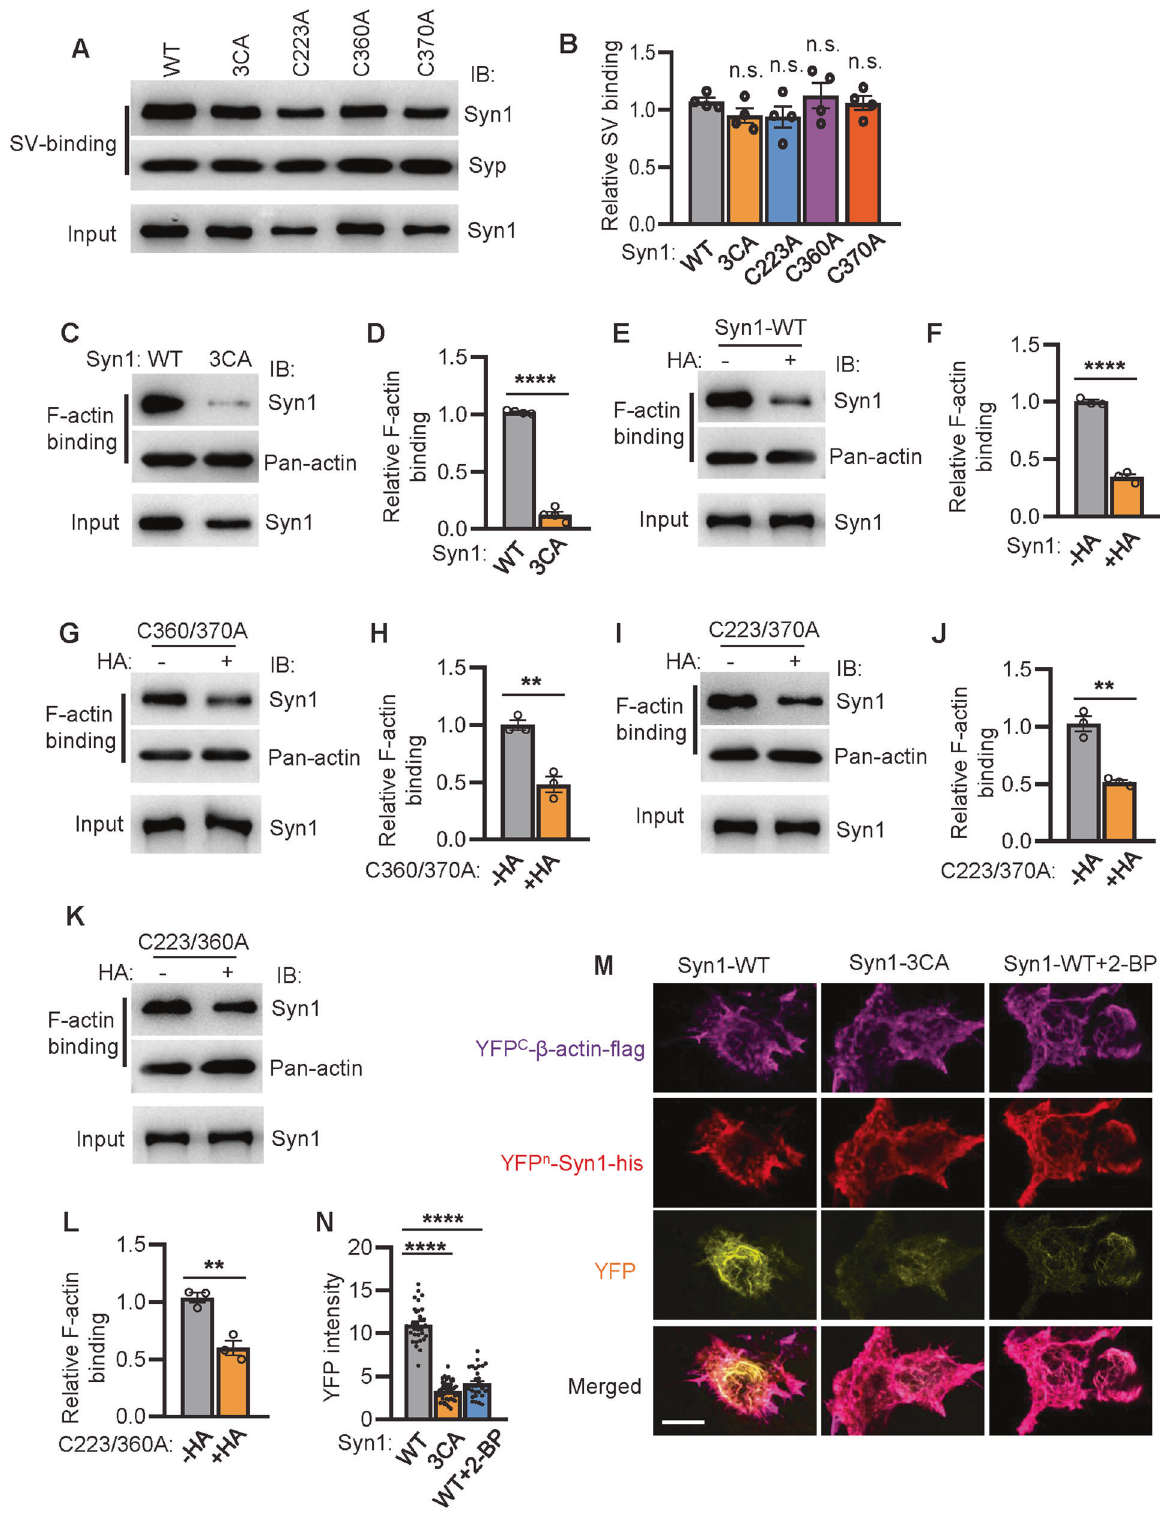
Fig. 4 Syn1 palmitoylation facilitates its binding with F-actin but not SVs. A , B SVs were extracted from WT mice brain and incubated with puri fi ed Syn1- fl ag or its mutants for af fi nity-binding assay. p > 0.1, one-way ANOVA, n = 4 biological replicates. C , D puri fi ed Syn1-WT and Syn1-3CA were incubated with actin and subjected for F-actin-binding assay ( n = 4 biological replicates, **** p < 0.0001). E , F puri fi ed Syn1- fl ag treated with or without HA (0.5 M for 2 h) was subjected for F-actin-binding assay ( n = 3 biological replicates, **** p < 0.0001). G – L puri fi ed Syn1-C360/370 A ( G , H , ** p = 0.0030), Syn1-C223/370 A ( I , J , ** p = 0.0018), or Syn1-C223/360 A ( K , L ** p = 0.0066) were treated with or without HA (0.5 M for 2 h) and subjected for F-actin-binding assays ( n = 3 biological replicates). M , N YFP n -Syn1-WT and YFP n -Syn1-3CA were coexpressed with YFP c - β -actin in HEK-293T cell for BiFC assays and the YFP fl uorescence was quanti fi ed ( n = 31 – 46 cells from 4 biological repeats). Scale bar, 10 μ m. One-way ANOVA, **** p < 0.0001. n.s., not signi fi cant. Data are mean ± s.e.m. Cell Death and Disease (2022)